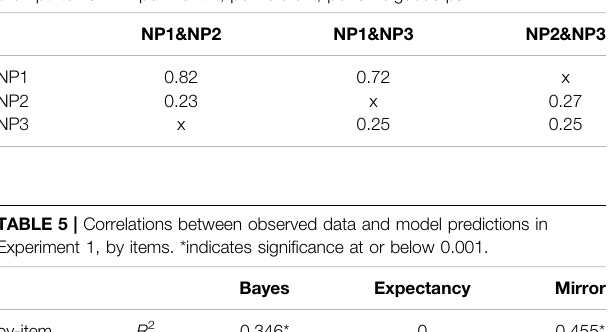
TABLE 4 | Proportion of pronominalization of ambiguous referents in the full stop prompt items in Experiment 1, per referent, per ambiguous pair.